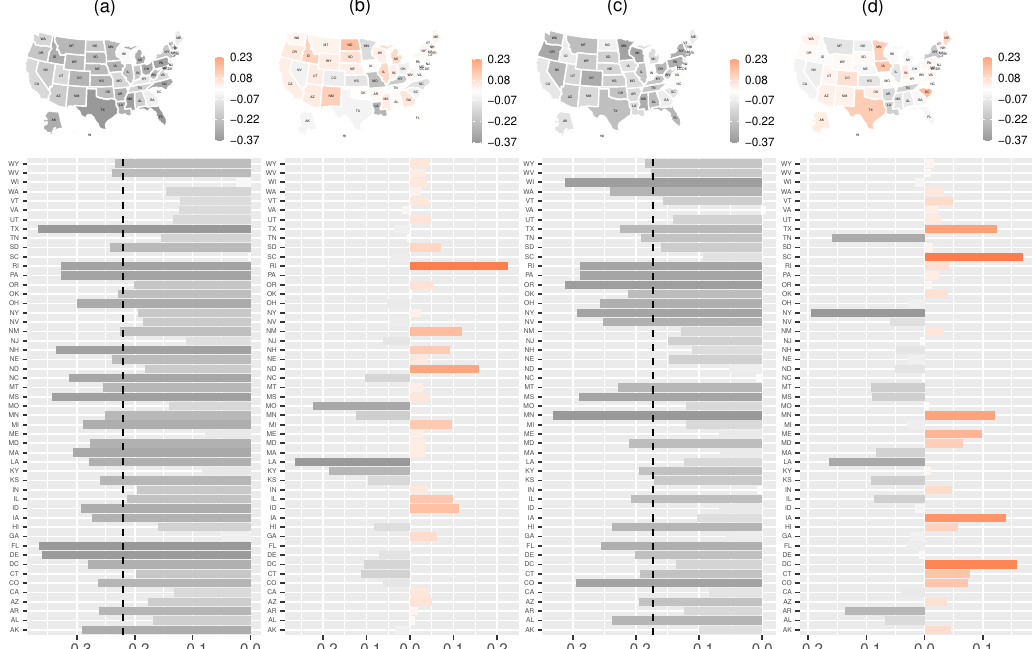
Figure 5. State-level estimated random effects in the multivariate time series model for (a) epidemic-within component V ( λ ) ; (b) epidemic-between component V ( ψ ) ; (c) epidemic-boosted component V ( θ ) and (d) endemic component V ( ζ ) . Vertical dotted lines in (a) and (b) are α ( λ ) and α ( θ ) . There is a strong variation in all four components, and different random effects for different states have various influence.